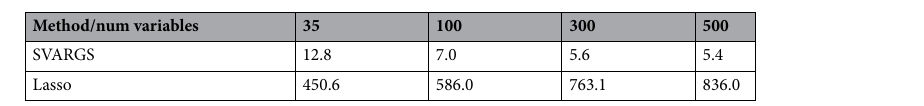
Table 2. Percent Spurious = Number of spurious predictions for every 100 true non-zero coefficients [For each system size, average over all simulations]